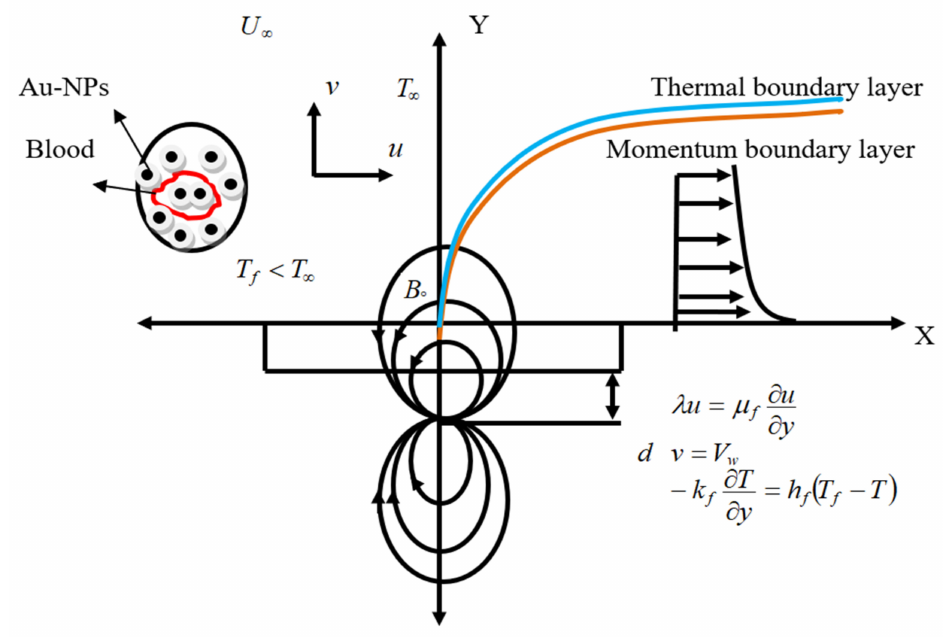
Figure 1. The geometry of the